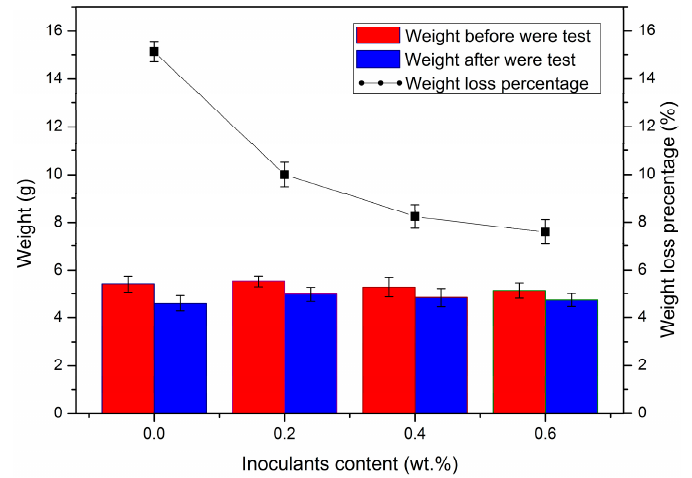
Figure 15. The friction and wear test result of TMCs with a different inoculants content.